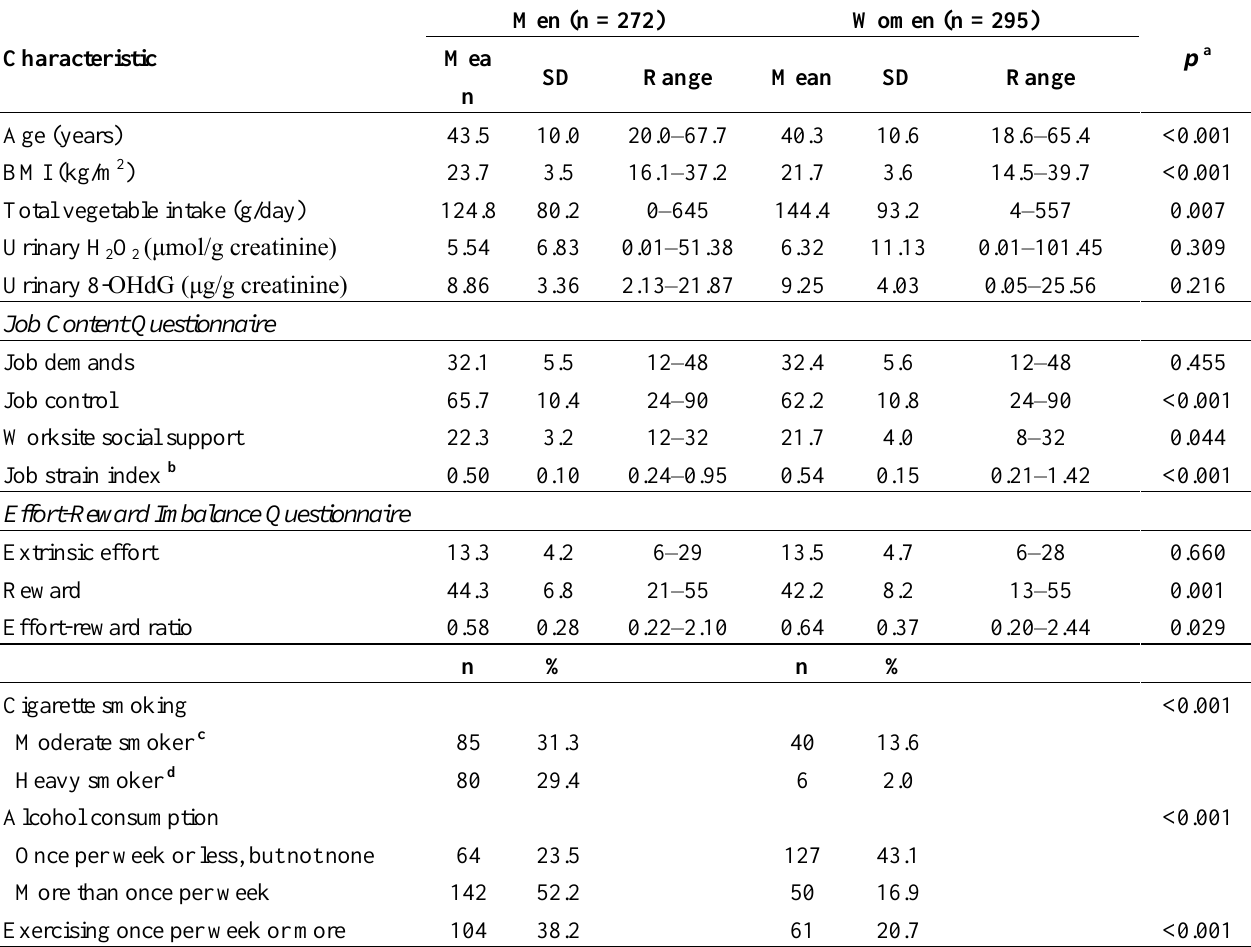
Table 1. Participant characteristics according to